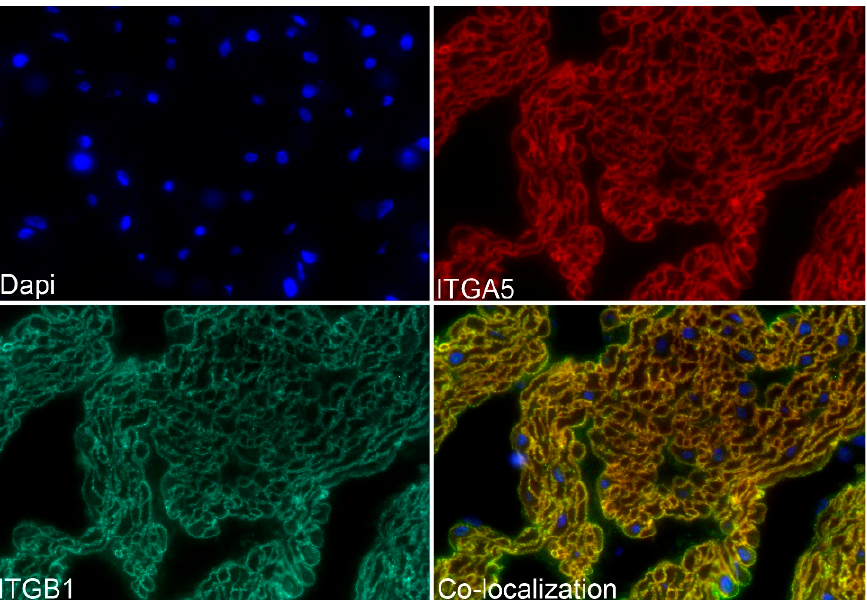
Figure 5. Double-immunostaining for alpha 5 integrin (ITGA5, red color) and beta 1 integrin (ITGB1, green color) in the myometrium of ewes on Day 80 of pregnancy is shown. ITGA5 and ITGB1 precisely co-localized to the same regions on the surface of the myometrial cells (yellow color), confirming the presence of the ITGA5B1 integrin receptor. DAPI was used to stain nuclei for histological reference. The width of each field is 220 µm.